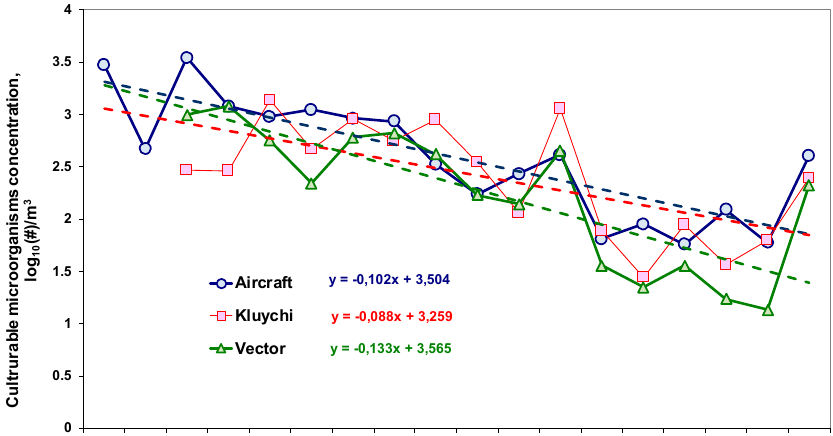
Figure 5. Trends of average annual concentrations of culturable microorganisms in the atmospheric aerosol in the south of Western Siberia. The average annual values with root mean square deviations (standard deviations) from the mean are given.